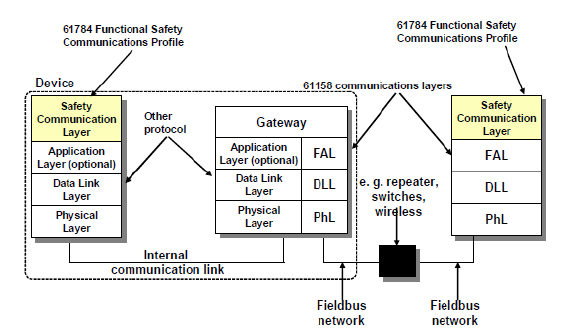
Fig. 5. Implementation of a safety layer over a standard fieldbus communication system The role of the safety profile or layer is to detect all the possible errors that may lead to the loss or the corruption of the